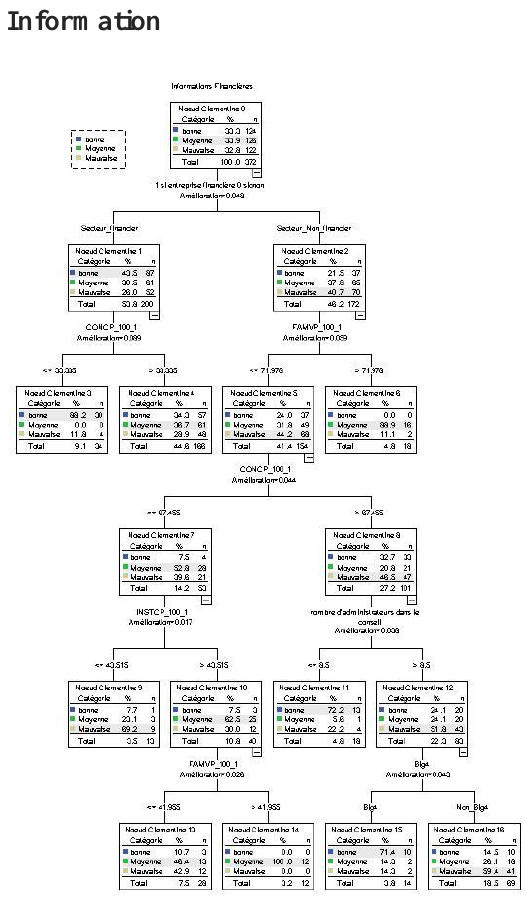
Figure VI – Decision Tree: Financial Information